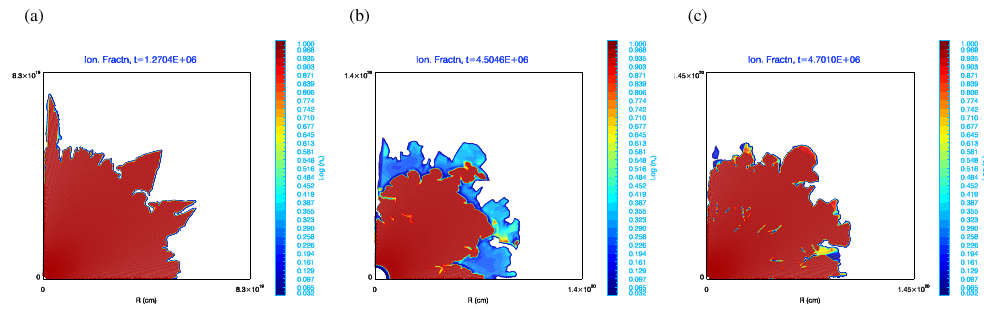
Figure 3. Evolution of the ionization fraction of the wind blown nebula over the various stages of the star’s life. ( a ) MS phase: the nebula is fully ionized. ( b ) RSG phase: the cooler star can no longer keep the HII region ionized, and it begins to recombine. ( c ) W-R phase: the hot star re-ionizes almost the entire